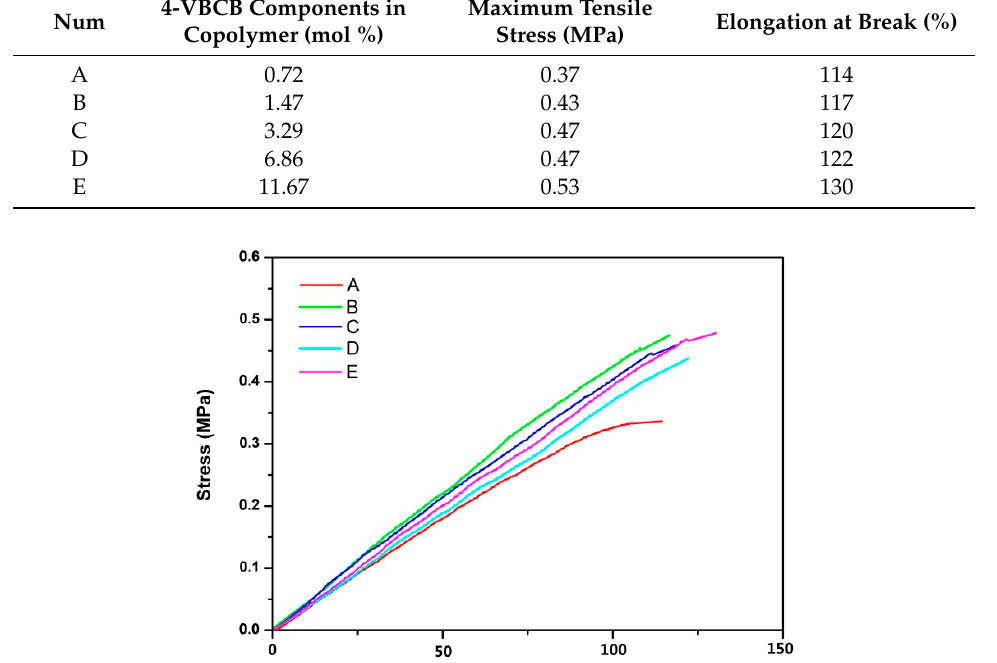
Figure 10. Stress-strain behavior of poly(IB- co -4-VBCB) after thermal crosslinking (A, B, C, D, and E correspond to the terms in Table 4).